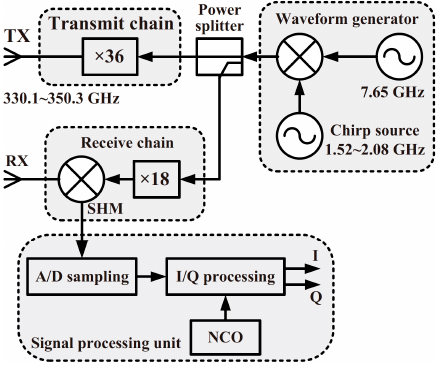
Figure 2. Block diagram of the terahertz radar system. TX is transmitter, RX is receiver, SHM is subharmonic mixer, A/D is Analog-to-Digital, I/Q is In-phase/Quadratic and NCO is numerically controlled oscillator.